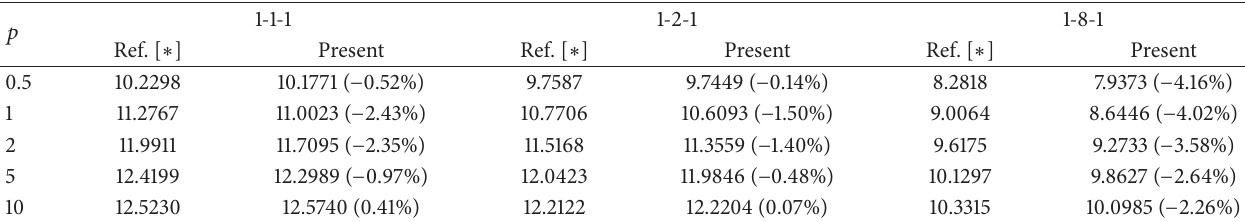
Table 3: Comparison of the nondimensional fundamental natural frequencies ( 𝑤 ) with various thickness ratios of the sandwich beam ( 𝐿/𝐻 = 20